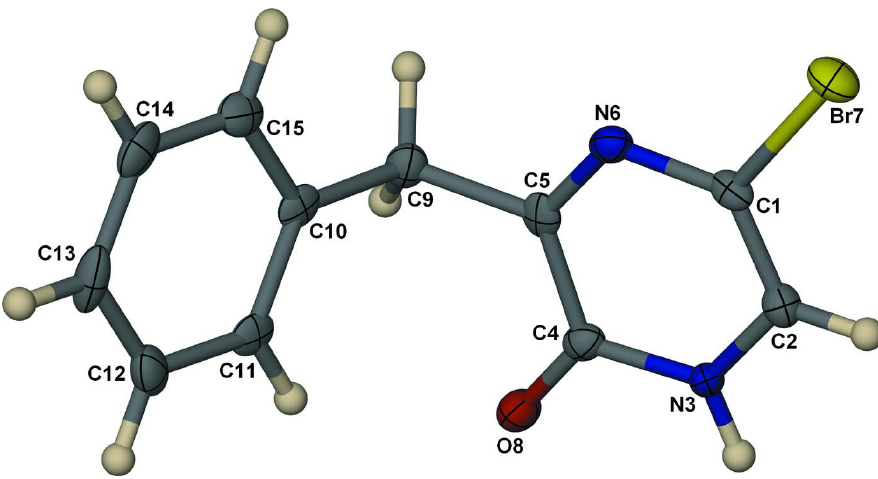
Figure 1 The molecular structure of (I) with the atom-numbering scheme. Displacement ellipsoids are drawn at the 50% probability level. H atoms are shown as spheres of arbitrary radii.